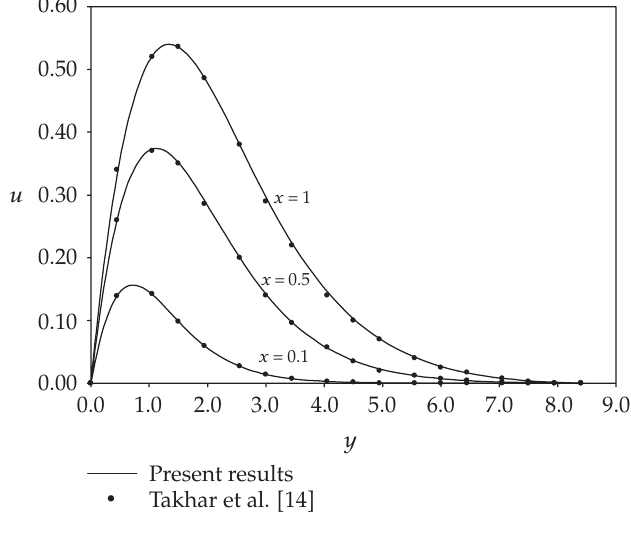
Figure 4.1 . Comparison of steady-state velocity profiles at di ff erent values of x .